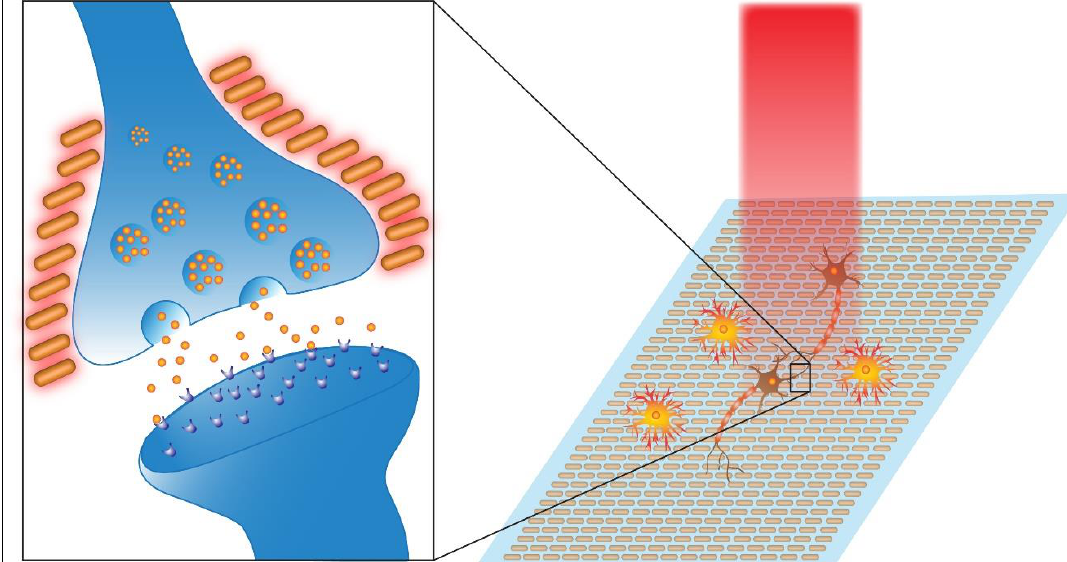
Figure 2. Events that could occur during the activation of plasmonic nanofactors (PNF). The insert shows that Ca 2 + channels could be opened as a result of local heat generated by PNF, which leads to an increase in the Ca 2 + concentration inside the neural terminal and the subsequent release of excitatory neurotransmitters that can depolarize the postsynaptic membrane, increasing the likelihood of action potential generation.